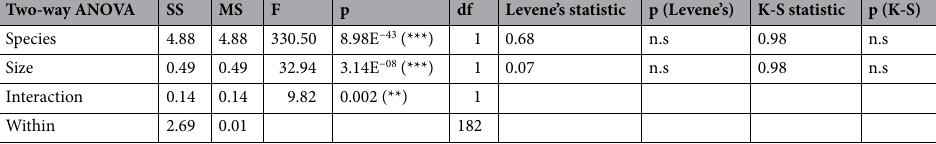
Two-way ANOVA SS MS F p df Levene’s statistic p (Levene’s) K-S statistic p (K-S) Species 4.88 4.88 330.50 8.98E −43